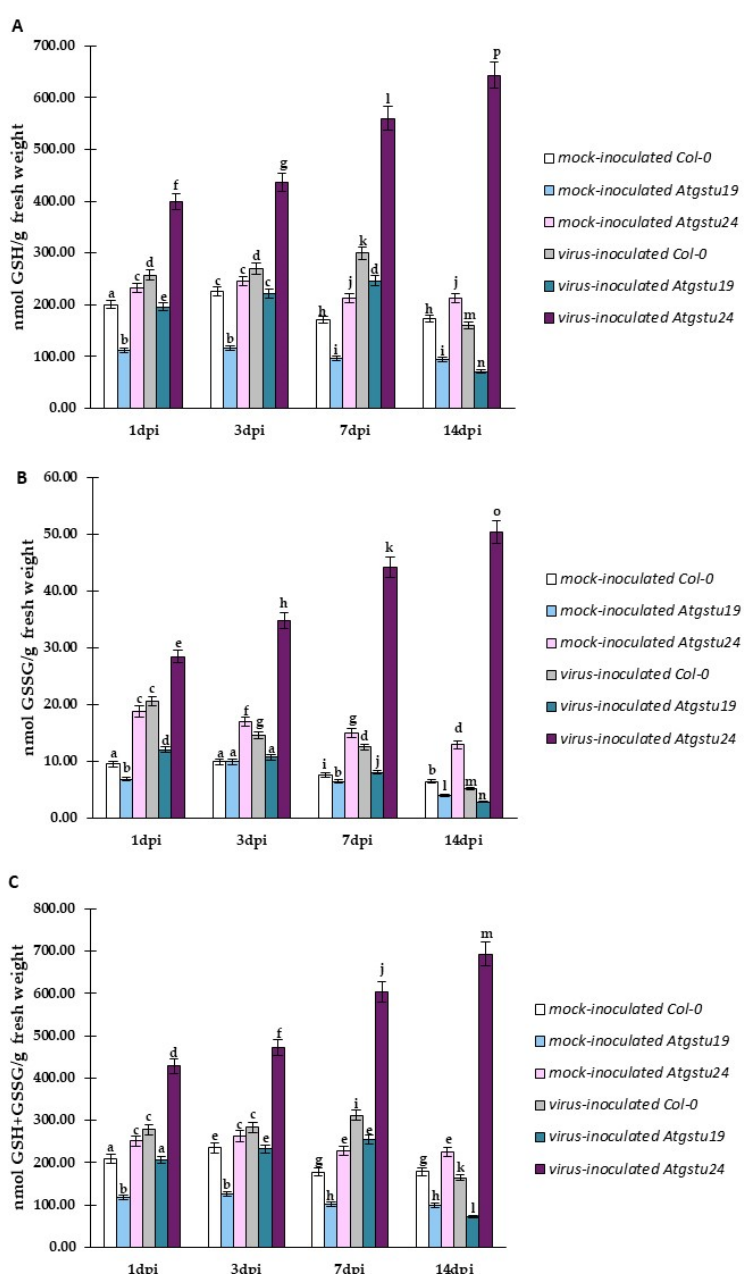
Figure 5. The mean concentration of GSH ( A ) and GSSG ( B ) glutathione in the leaves of TuMV and mock-inoculated Col-0, Atgstu19 , and Atgstu24 plants between 1 and 14 dpi. ( C ) The mean of the total concentration of GSH and GSSG glutathione in the leaves of TuMV- and mock-inoculated Col-0, Atgstu19 , and Atgstu24 plants between 1 and 14 dpi. Using ANOVA and Tukey’s HSD test, the mean concentrations of GSH and GSSG were calculated at p < 0.05. Statistically significant values are indicated by letters above the